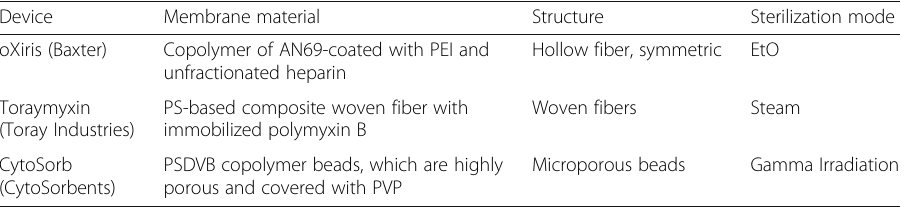
Table 1 Characteristics of investigated blood purification devices Device Membrane material Structure oXiris